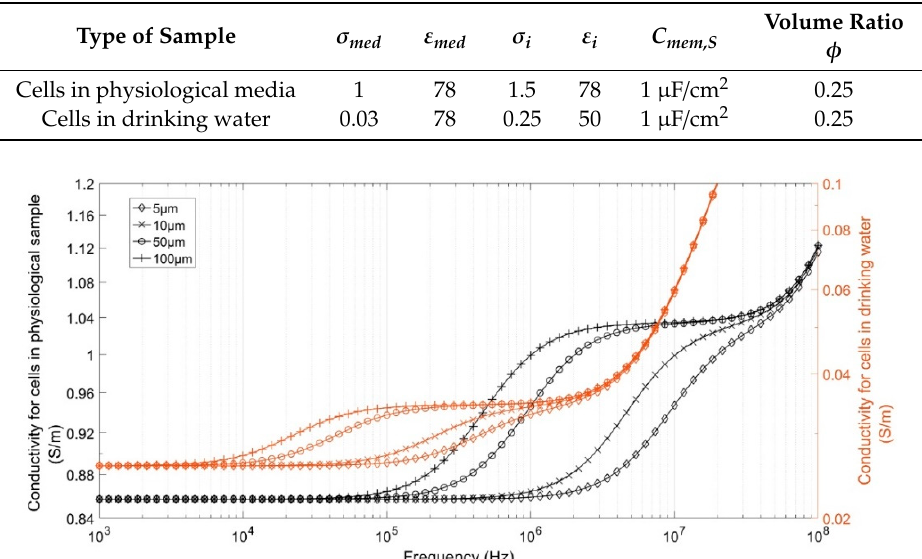
Table 1. Parameters used for samples conductivity calculation.